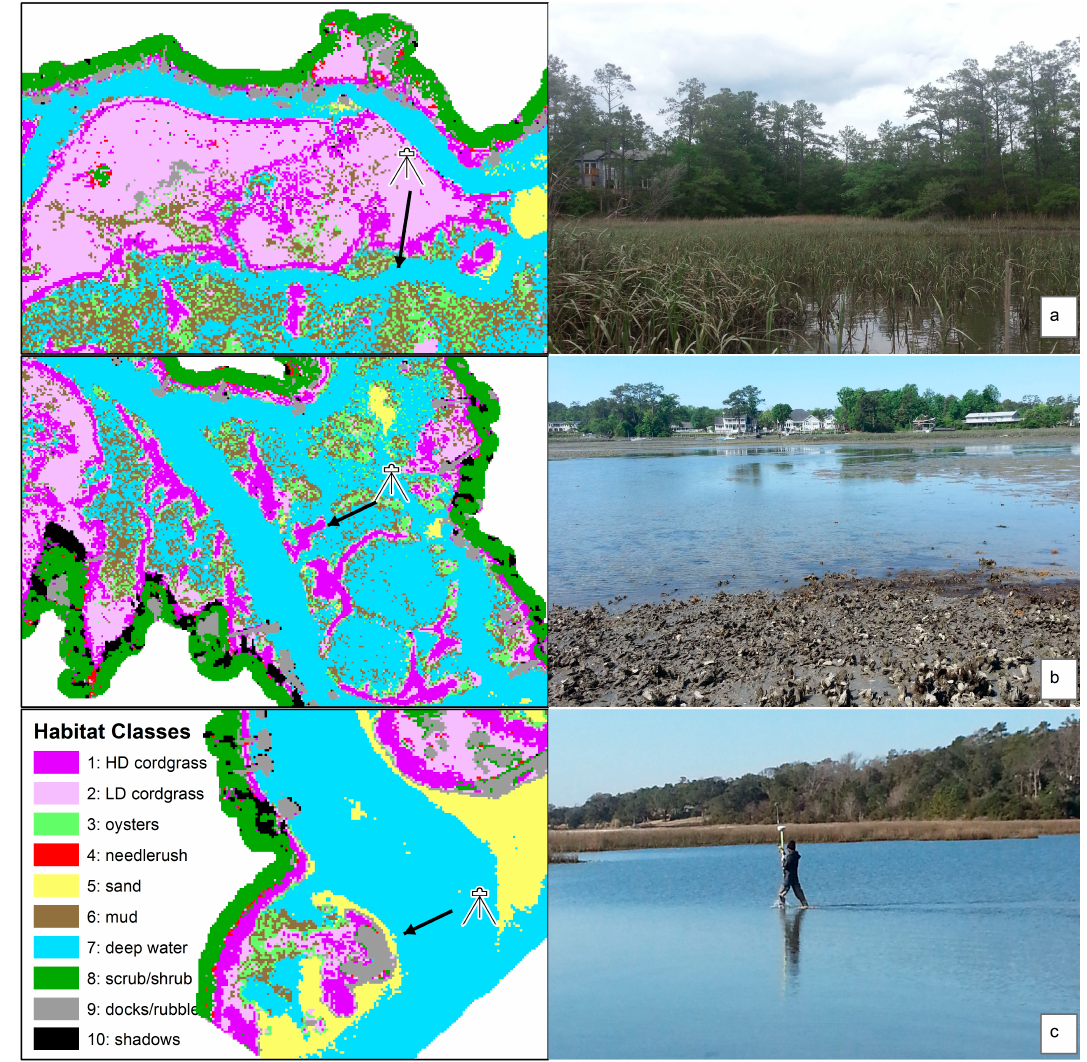
Figure 6. Example locations in the study area: ( a ) upper reach with low-density cordgrass in the foreground and high-density cordgrass in the background; ( b ) middle reach with mud and oysters in the foreground; and ( c ) estuary mouth of the creek. Camera location and direction are included in each map.